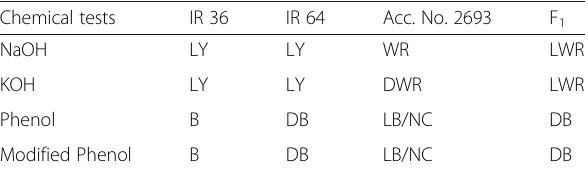
Table 1 Aleurone layer color reaction of parents and F 1